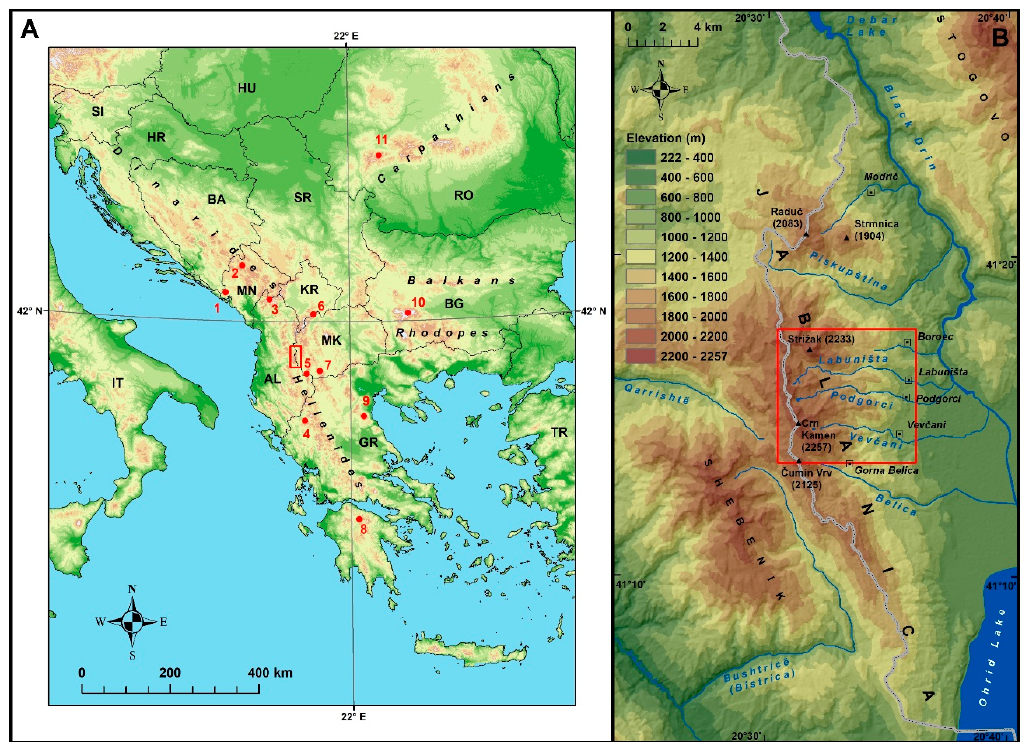
Figure 1. Location of Jablanica Mountain in the Balkan Peninsula ( A ) and a closer look at the general morphology of the mountain ( B ) with red rectangle showing the study area. Mountain ranges mentioned in text are shown by numbers: 1—Orjen Mt., 2—Durmitor Mt., 3— Prokletije Mts., 4—